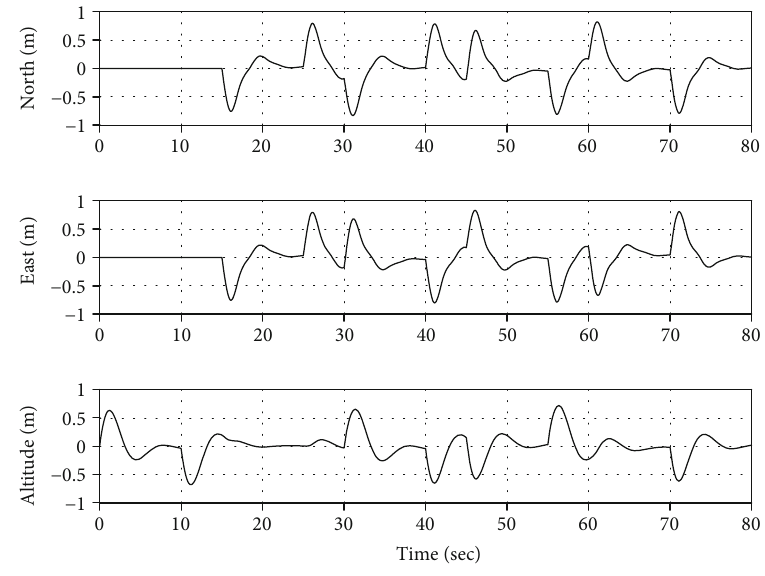
Figure 10: Time history of position error.